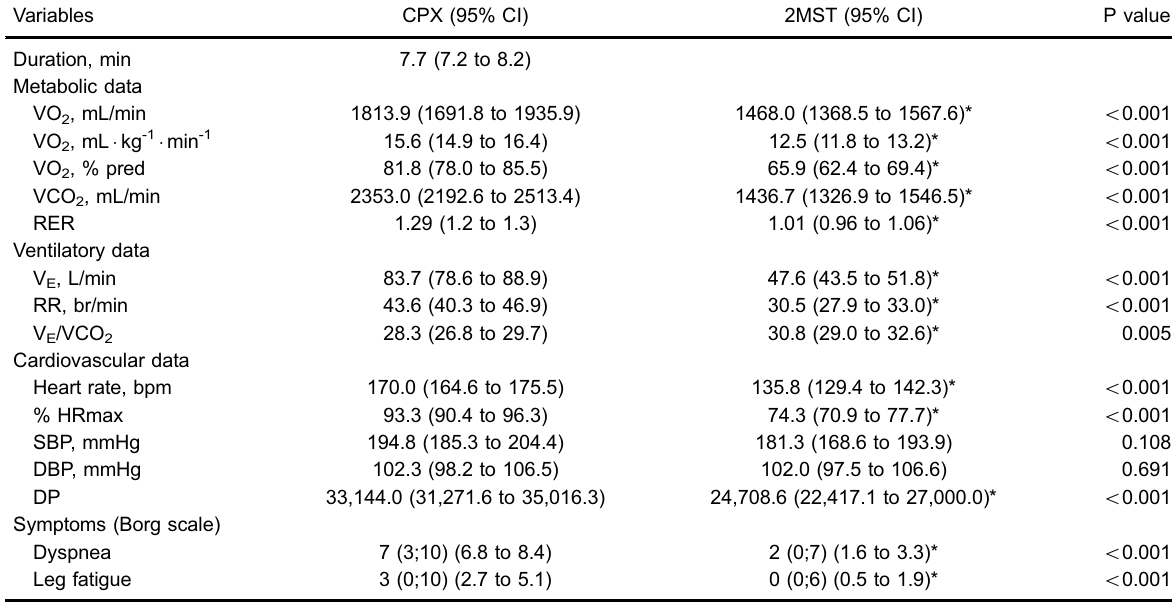
Table 2. Variables at the peak of the cardiopulmonary exercise test (CPX) and of the two-minute step test (2MST).